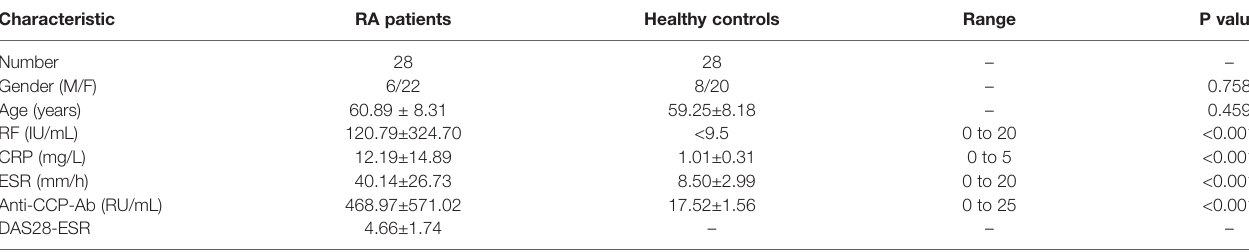
TABLE 1 | Clinical features of the patients and the healthy controls included in the study. Characteristic RA